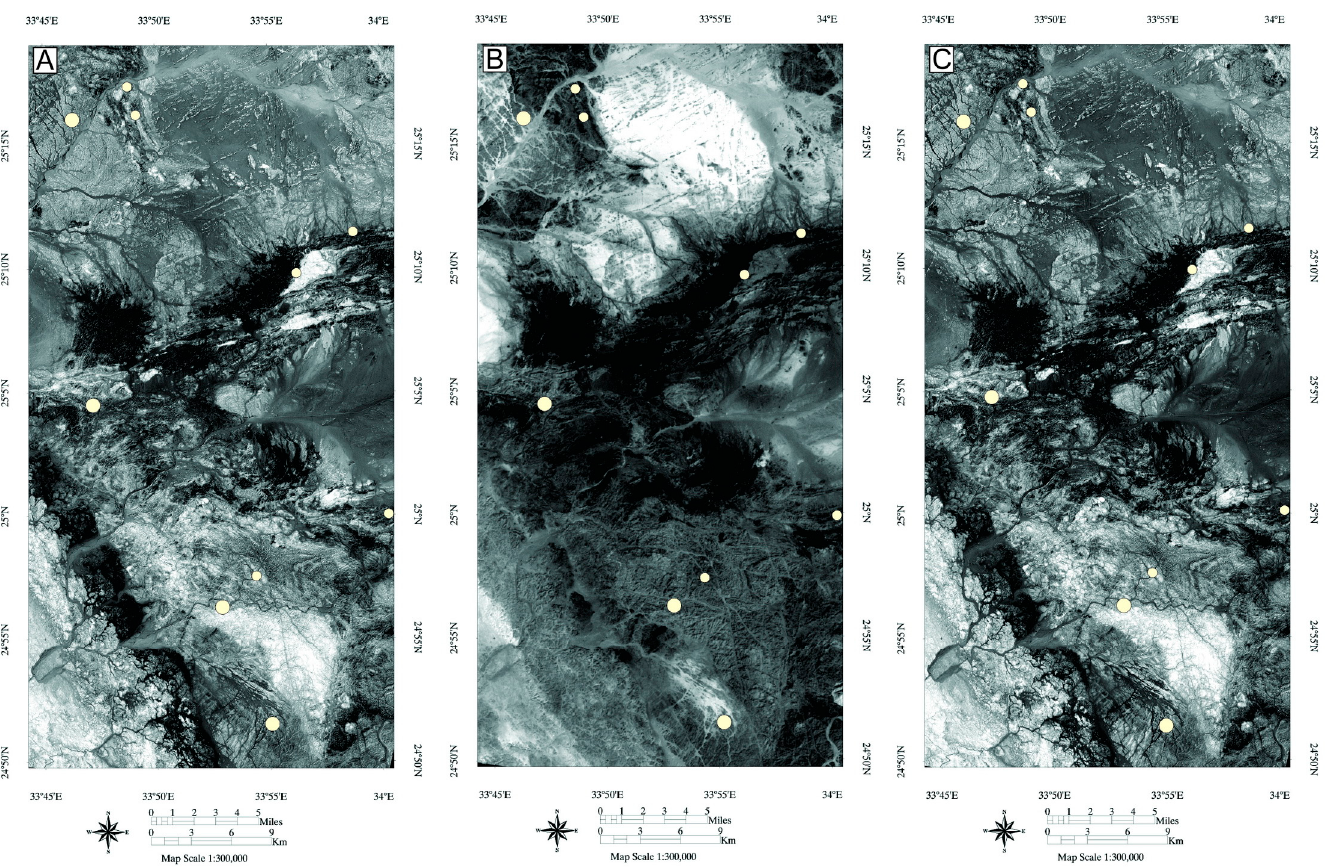
Figure 8. ASTER band ratio indices used to detect the hydrothermal alteration zones in the study area: ( A ) Band4 / band2 image for mapping gossan zones, ( B ) Band4 / band3 image for mapping ferric oxide-rich rocks, and ( C ) Band7 + band9 / band8 image for mapping chlorite / epidote / clacite-rich rocks. White circles are locations of gold deposits / occurrences.